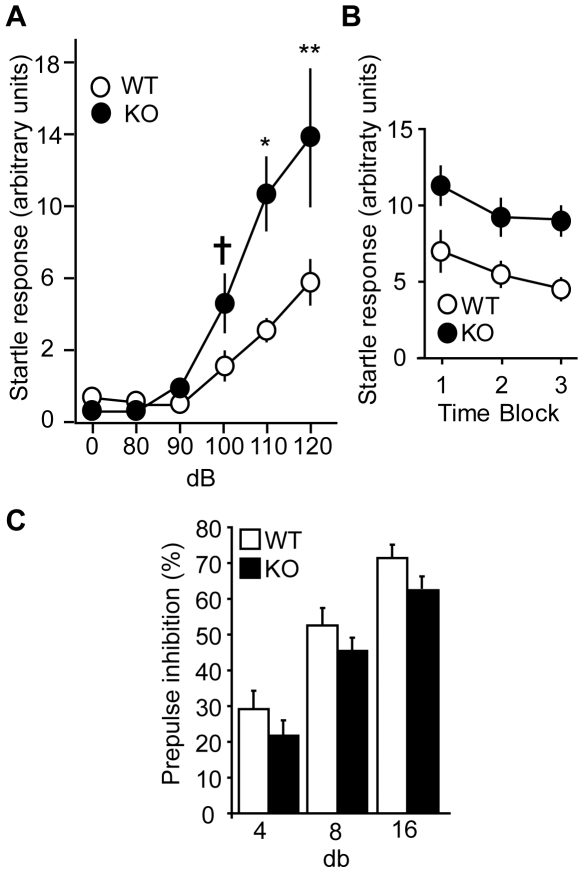
Increased acoustic startle reactivity with normal short-term acoustic habituation and prepulse inhibition in Cdk5 KO mice.
A, Acoustic startle reactivity in Cdk5 KO mice (4–8 weeks post-KO, n = 17–19). ANOVA revealed a main effect of genotype (F1,204 = 16.35, p<0.0001), decibels (F5,204 = 19.67, p<0.0001) and interaction between genotype and decibels (F5,204 = 3.72, p = 0.003). *P<0.01, **P<0.001, †P = 0.08 vs. WT, post hoc t-test. B, Habituation to a 120 db sound is shown as startle reactivity in three consecutive time blocks. ANOVA revealed effects of genotype (F1,68 = 8.62, p<0.006) and trial (F2,68 = 14.65, p<0.0001) but no interaction between genotype and trial (F2,68 = 0.31, p = 0.7326). n = 17–19. C, Prepulse inhibition in Cdk5 KO mice. Prepulse at indicated decibels were given 5 ms prior to a 120 db sound. Prepulse inhibition is represented as percent decrease compared to an isolated 120 db sound. ANOVA revealed effect of decibel (F2,32 = 143.74, p<0.0001) but no effect of genotype (F1,32 = 2.03, p = 0.1735) or interaction (F2,32 = 0.78, p = 0.469). n = 8–10. Vehicle-treated animals behaved similarly to WT. Data represent mean±s.e.m.